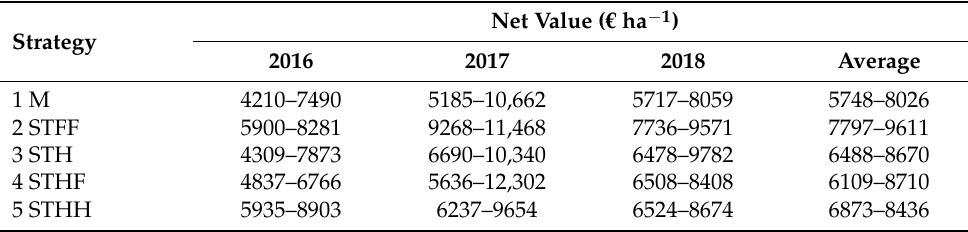
Table 10. Net value ( € ha − 1 ) (95% confidence interval) for each year and the average of the three years.